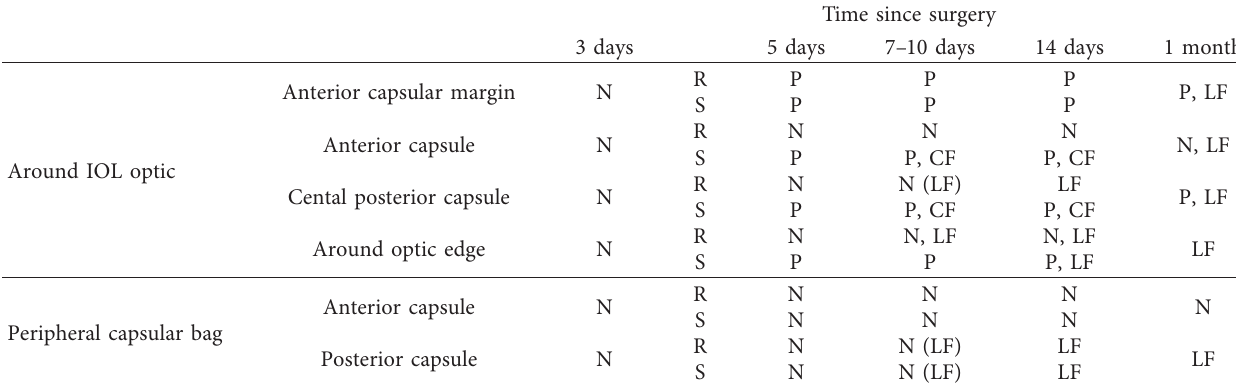
Figure 5: Immunolocalization of α -SMA in pseudophakic rabbit eyes 1 month after cataract surgery. (a) The capsular bag is filled with lens fibers. Differentiated LECs are also present between the anterior surface of the IOL optic and the anterior capsule. Some of these lens fibers migrated beyond the anterior capsule margin and formed posterior synechia to the iris (arrow). The lens fibers migrated onto the posterior capsule from the periphery to the center (arrowhead), which showed no LECs. Bar � 800 μ m. (b) Higher power view of LECs around the margin of the anterior capsule (arrow). The arrowhead indicates the posterior synechia of the lens fibers to the iris. Bar � 250 μ m. (c) Higher power view of lens fibers on the central posterior capsule. Differentiated LECs, which form the Elschnig pearls type of opacification, are present over the α -SMA-positive LECs attached to the wrinkled posterior capsule (arrows). Bar � 250 μ m. (a–c) Sections were stained with 3- 3’-diaminobenzidine hydrochloride and counterstained with hematoxylin. The asterisks indicate the IOL optic. Table 1: Immunohistological results of